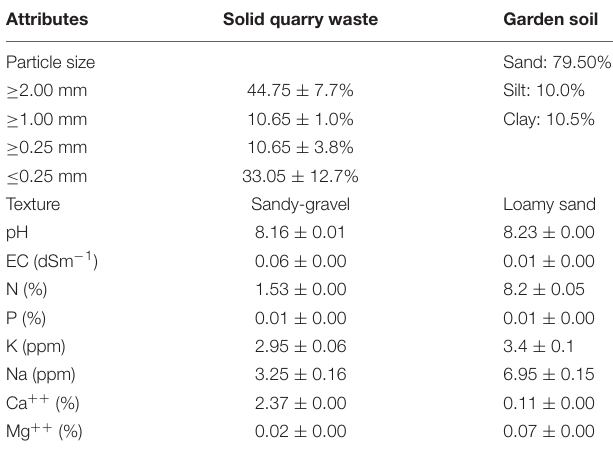
TABLE 2 | Physicochemical analyses of solid quarry waste and garden soil.